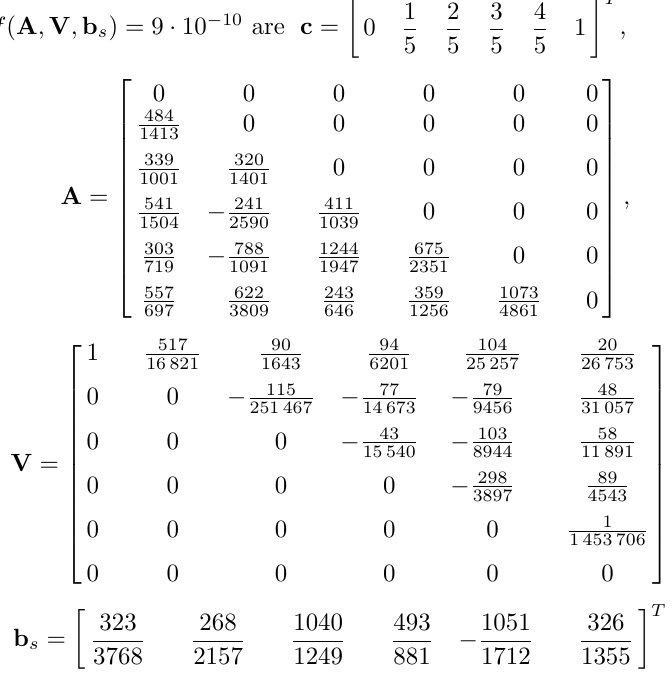
which f ( A , V , b s ) = 9 · 10 − 10 are c